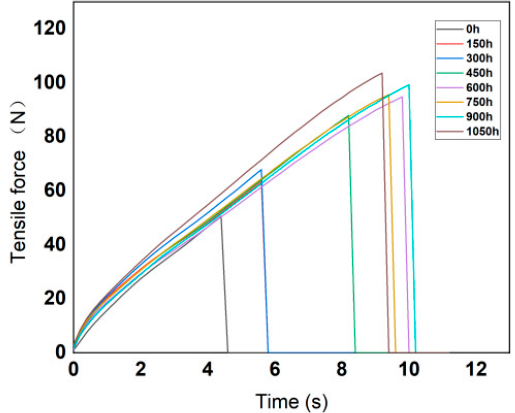
Figure 5. Variation curves of silicone rubber tensile force with